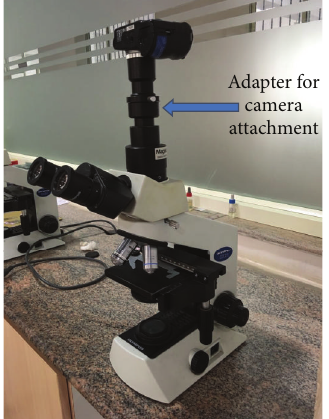
Figure 1: Basic setup required for capturing photomicrographs.